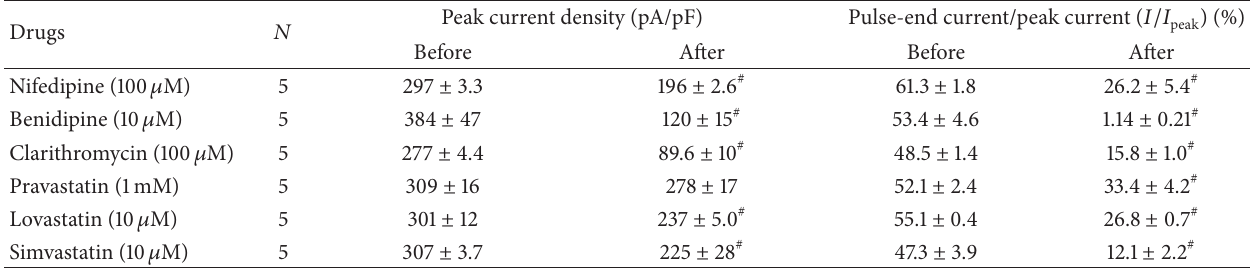
Table 1: Summary of changes in peak and pulse-end currents after application of CCBs, macrolide, and HMG-CoA reductase inhibitors (statins).